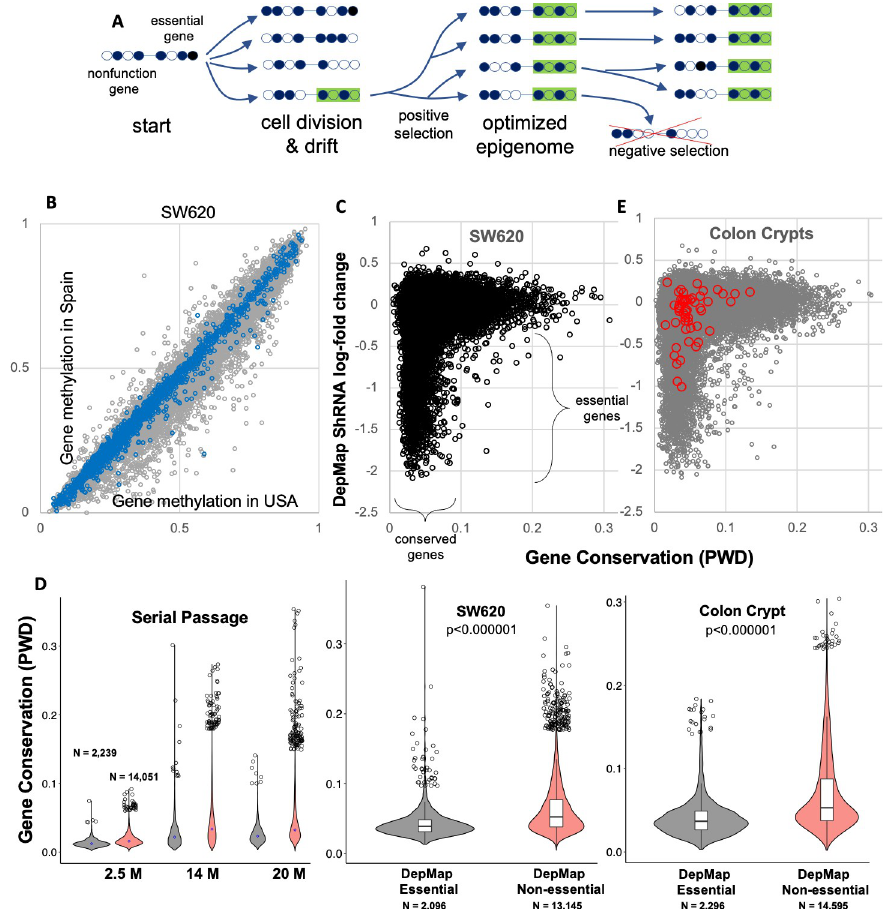
Fig 1. DepMap essential genes exhibit preferential epigenetic conservation. A) Diagram of how drift and selection cause preferential epigenetic conservation. Initially identical daughter cells acquire epigenetic differences from drift. Cells with more optimal epigenomes (green) will be more fit and dominate the population. Once an epigenome is optimized, negative selection will tend to conserve the favored epigenetic configuration because variants are lost. Drift still occurs but changes are more tolerated in less functional genes, leading to preferential conservation of the genes under selection. The more essential a gene is to cell survival, the greater the selection and conservation. Circles indicate CpG sites, with filled circles indicating DNA methylation. B) Gene DNA methylation varies between two samples of the SW620 CRC cell line cultured in the USA and Spain. Smaller differences in methylation are present for DepMap essential genes (blue dots). C) DepMap essential genes (shRNA log-fold decrease less than -0.4) showed significantly smaller gene PWDs than non-essential genes. D) Essential genes are significantly more conserved (lower PWDs) than non-essential genes (red symbols) in tissue culture and normal colon crypts. Essential and non-essential genes in colon crypts were significantly less conserved than after 20 months of serial passage of a clonal cell line (p < 0.000001). E) Essential DepMap genes are also significantly more conserved in normal human colon. Conservation differences are greater between normal adult colon crypts than between cell lines samples, likely reflecting the many more divisions that occur with aging relative to tissue culture. Most curated genes (red circles) important to colon crypt biology by other experimental criteria [10] are not essential by DepMap gene disruptions, but show preferential conservation, with gene PWDs less than